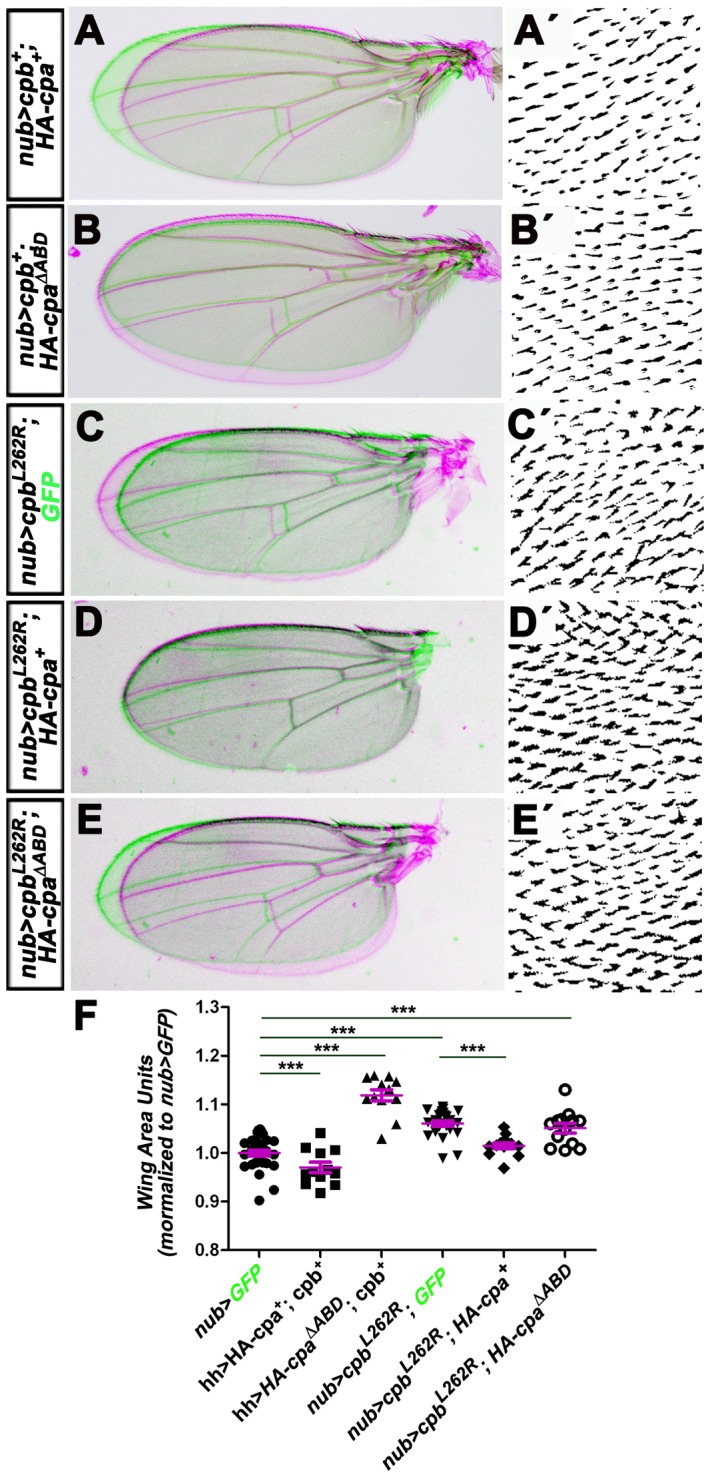
Overexpressing full length HA-cpa and cpb prevents wing growth, while ectopic expression of HA-cpaΔABD and/or cpbL262R has the opposite effect.(A, B, C, D and E) merge between adult wings expressing in green UAS-mCD8GFP under nub-Gal4 control and in magenta (A) UAS-HA-cpa89E and UAS-cpb7 or (B) UAS-HA-cpaΔABD and UAS-cpb7 or (C) UAS-cpbL262R and one copy of UAS-mCD8-GFP or (D) UAS-cpbL262R and UAS-HA-cpa89E or (E) UAS-cpbL262R and UAS-HA-cpaΔABD under nub-Gal4 control. (A′, B′, C′ D′ and E′) magnification of hairs on adult wings for the genotypes shown in A, B, C, D and E. (F) quantification of relative wing size normalized to nub>GFP control for nub-Gal4 driving UAS-mCD8-GFP (lane 1) or UAS-HA-cpa89E and UAS-cpb7 (lane 2) or UAS-HA-cpaΔABD and UAS-cpb7 (lane 3) or UAS-cpbL262R and one copy of UAS-mCD8-GFP (lane 4) or UAS-cpbL262R and UAS-HA-cpa89E (lane 5) or UAS-cpbL262R and UAS-HA-cpaΔABD (lane 6). The mean for lane 1 is 1(n = 32), for lane 2 is 0.9702 (n = 12), for lane 3 is 1.119 (n = 13), for lane 4 is 1.061 (n = 24), for lane 5 is 1.015 (n = 13), for lane 6 is 1.051 (n = 13). Error bars indicate s.e.m.. P<0.015 for comparison of lanes 1 and 2. P<0.0001 for comparison of lanes 1 and 3 or 4 or 6 and for comparison of lane 4 and 5.